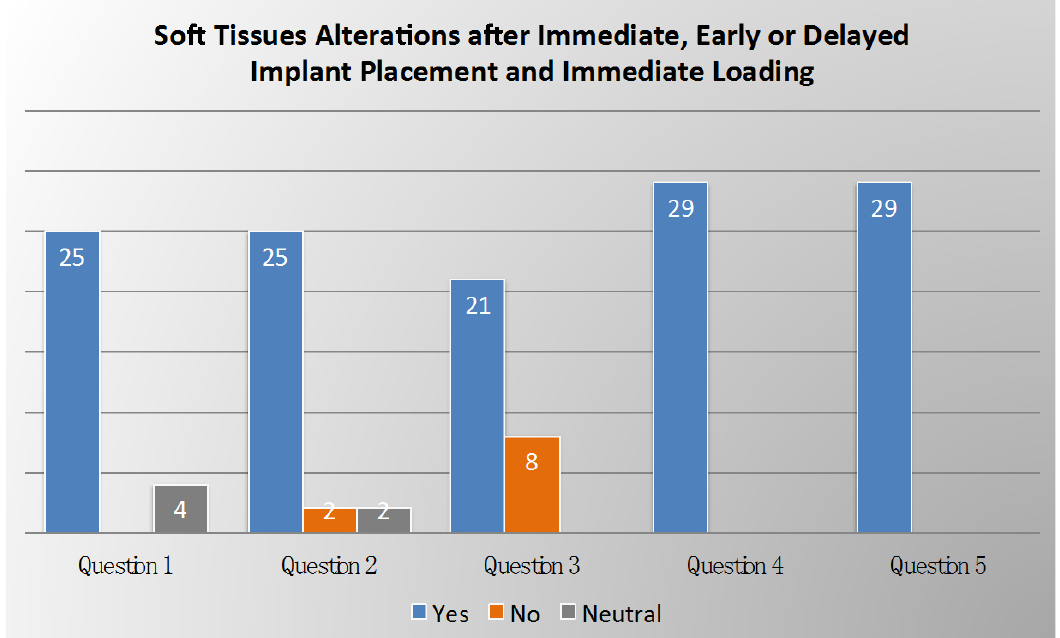
Figure 2. Voting results from the panel of experts on soft tissue alternations after immediate, early, or delayed implant placement and immediate loading.